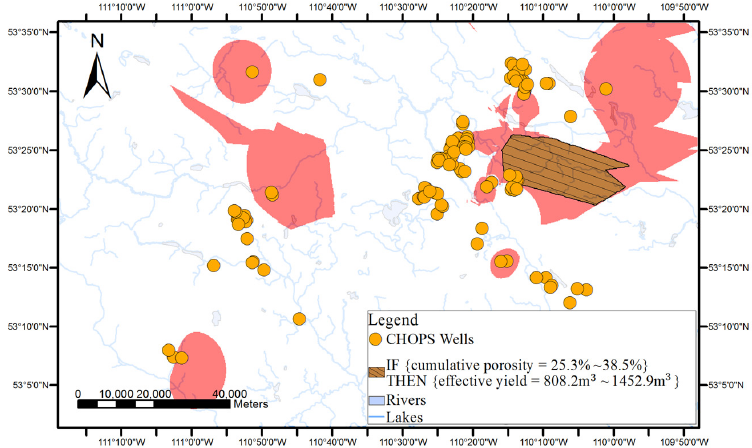
Figure 10. Surface-based geovisualization based on IDW interpolation of IF {cumulative porosity = 25.3%–38.5%} THEN {effective yield = 808.2–1452.9 m 3 }.